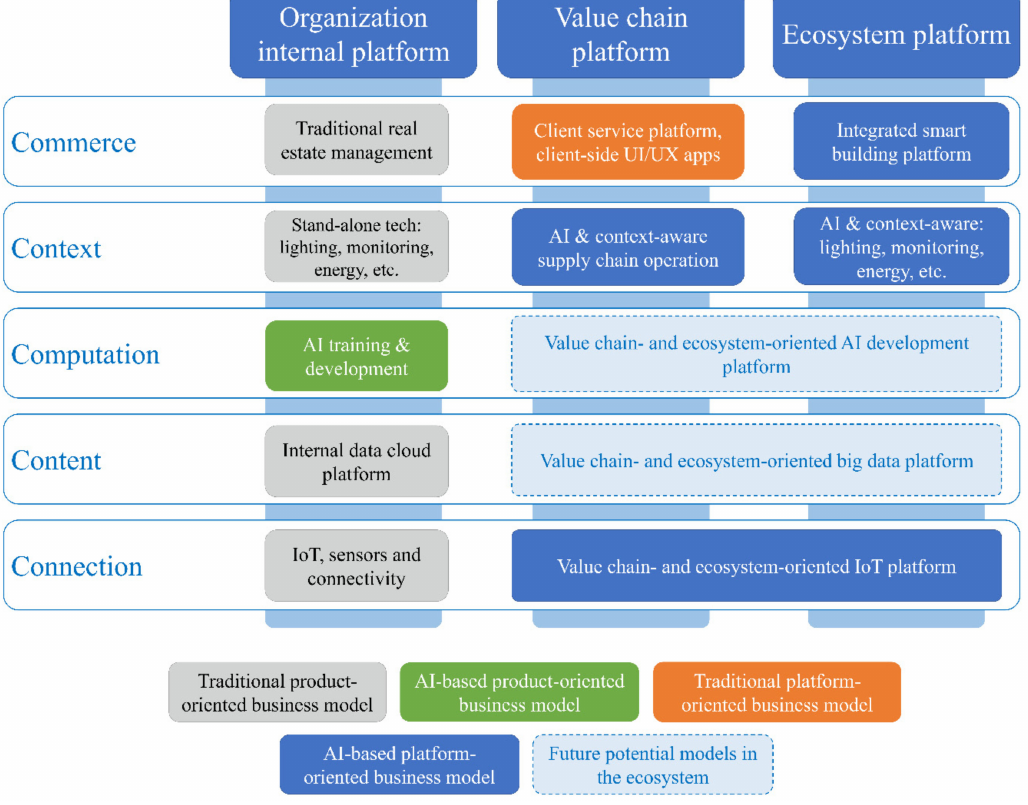
Figure 2. Overview of the research